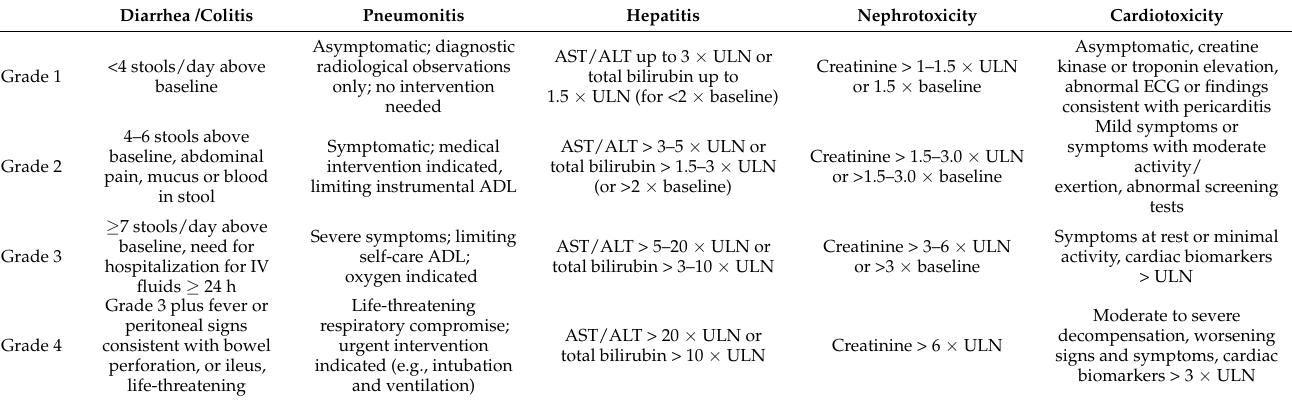
Table A2. Immune-related adverse event grading definitions utilized for data collection